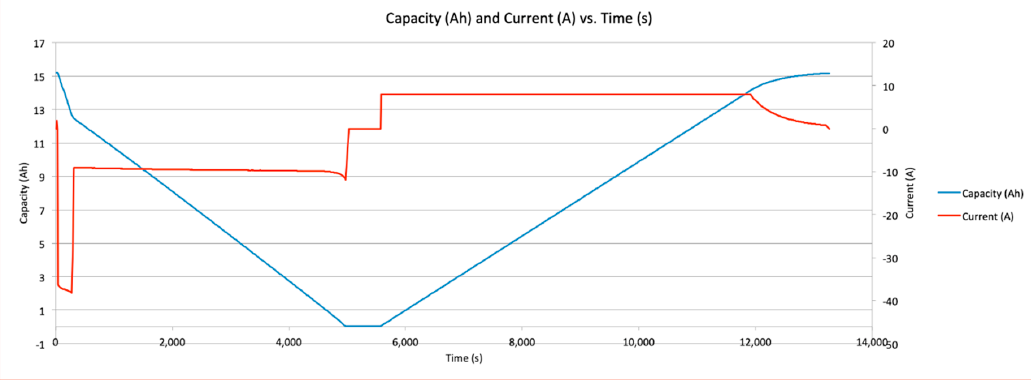
Figure 18. Battery individual cell testing under flight load profile: Capacity and current vs. time.